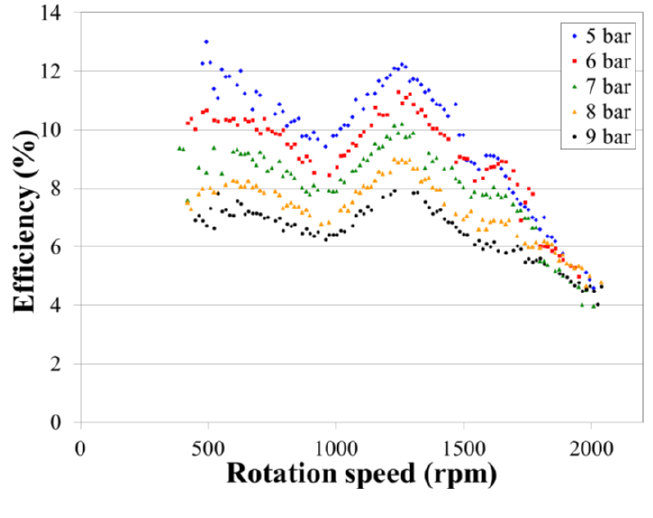
Figure 13. The calculated power efficiency of the compressed air engine at different rotation speeds and supplied air